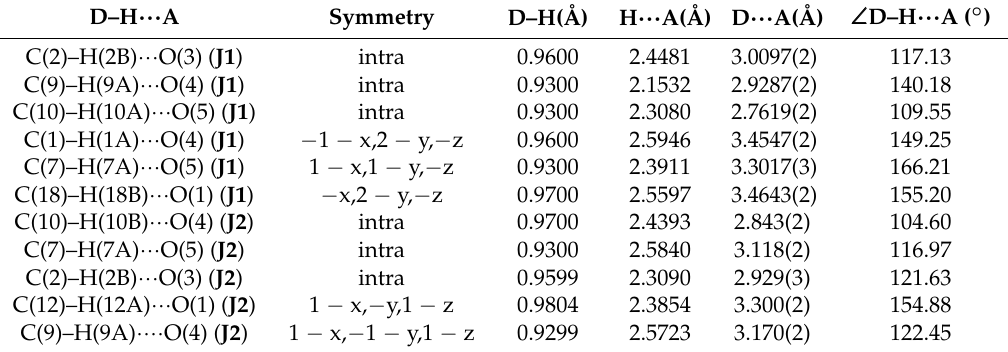
Table 3. Intra- and intermolecular hydrogen bond in J1 and J2 .